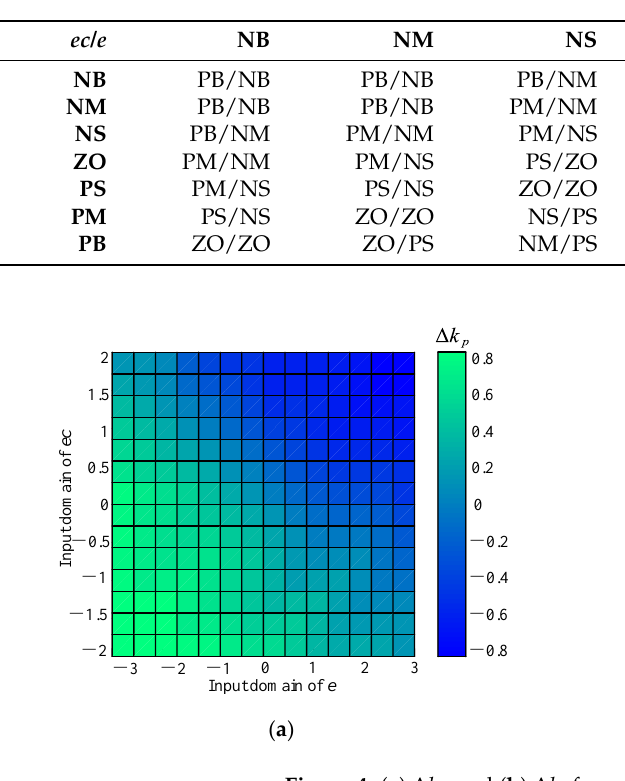
Table 1. Eigenroot values of the first three orders of flexible loads.